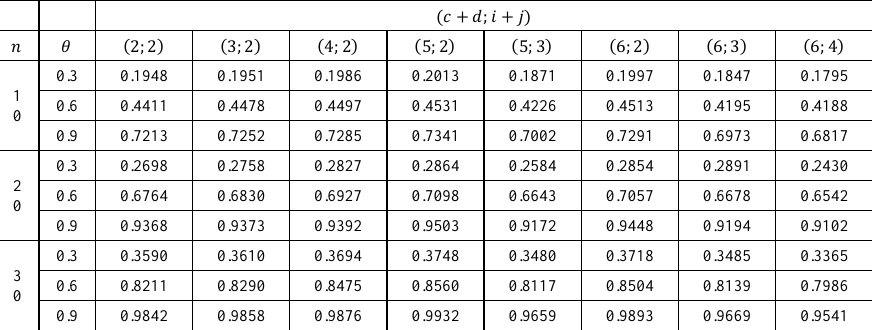
for Normal distribution 𝑐,𝑑;𝑖,𝑗 (𝑐 + 𝑑;𝑖 +